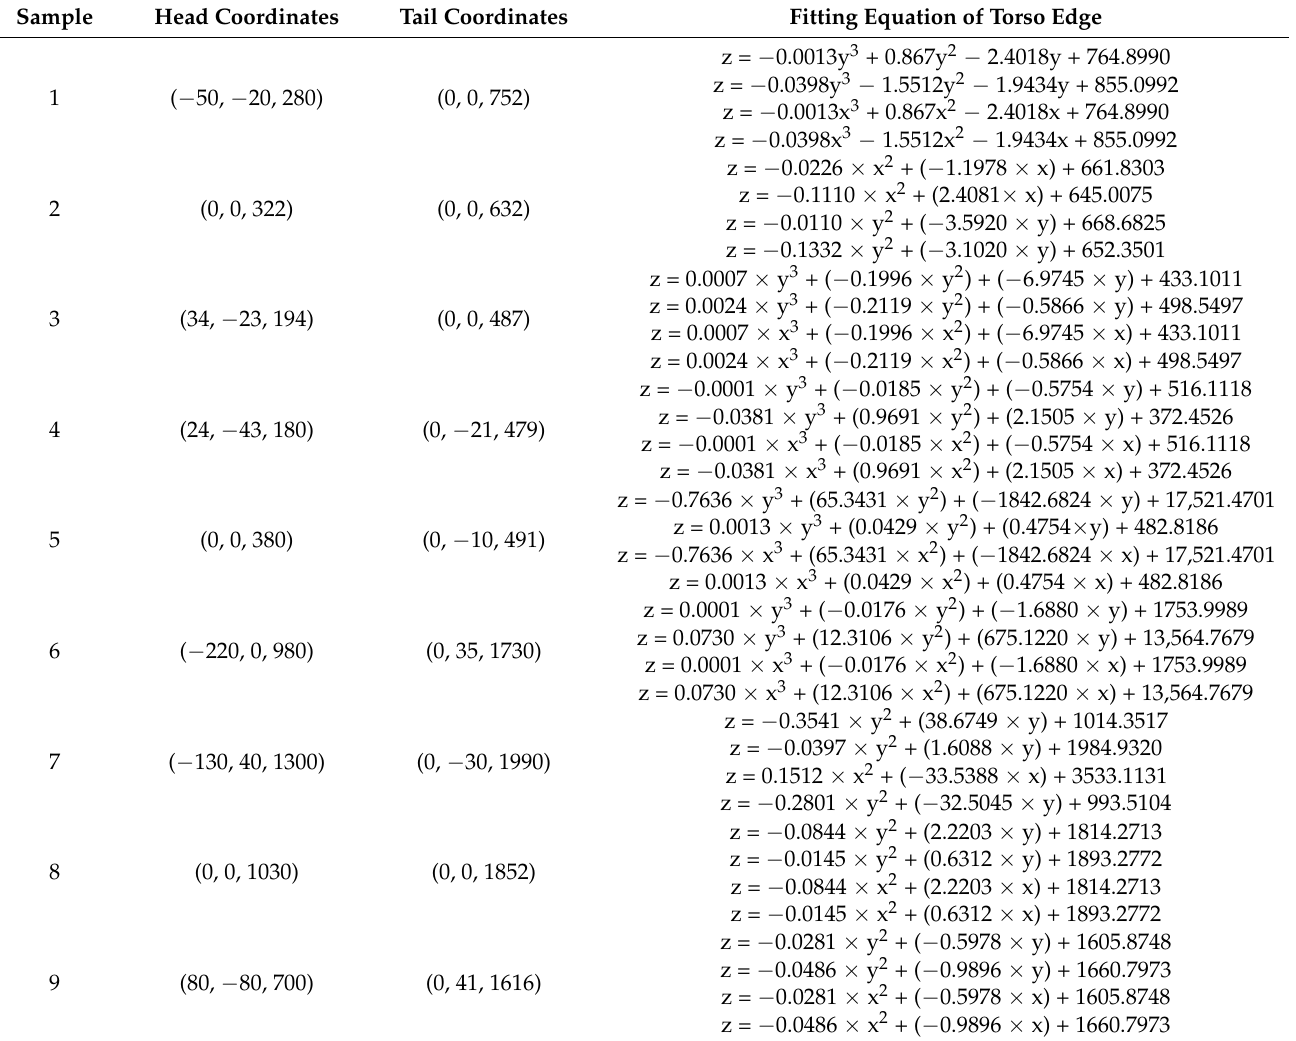
Table 2. 3D torso information of the samples, including 3D coordinates of head and tail, and corresponding fitted equation. The 3D coordinates of the head and tail are presented in image